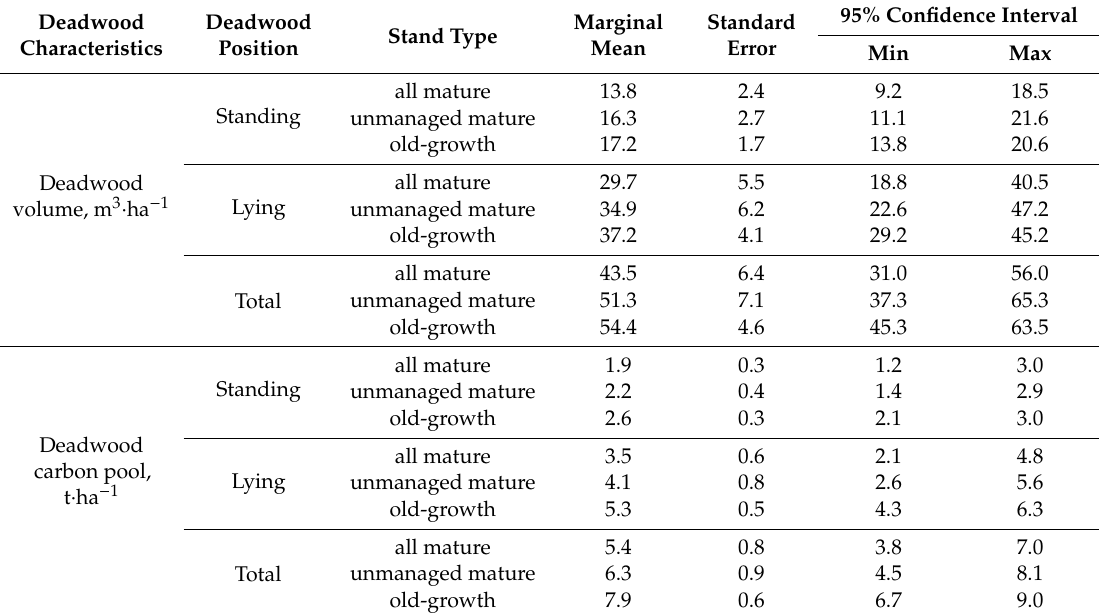
Table 1. Deadwood volume and deadwood carbon pool size in all mature (71–110), recently unmanaged mature (71–110), and old-growth (121–150) birch stands by deadwood position.